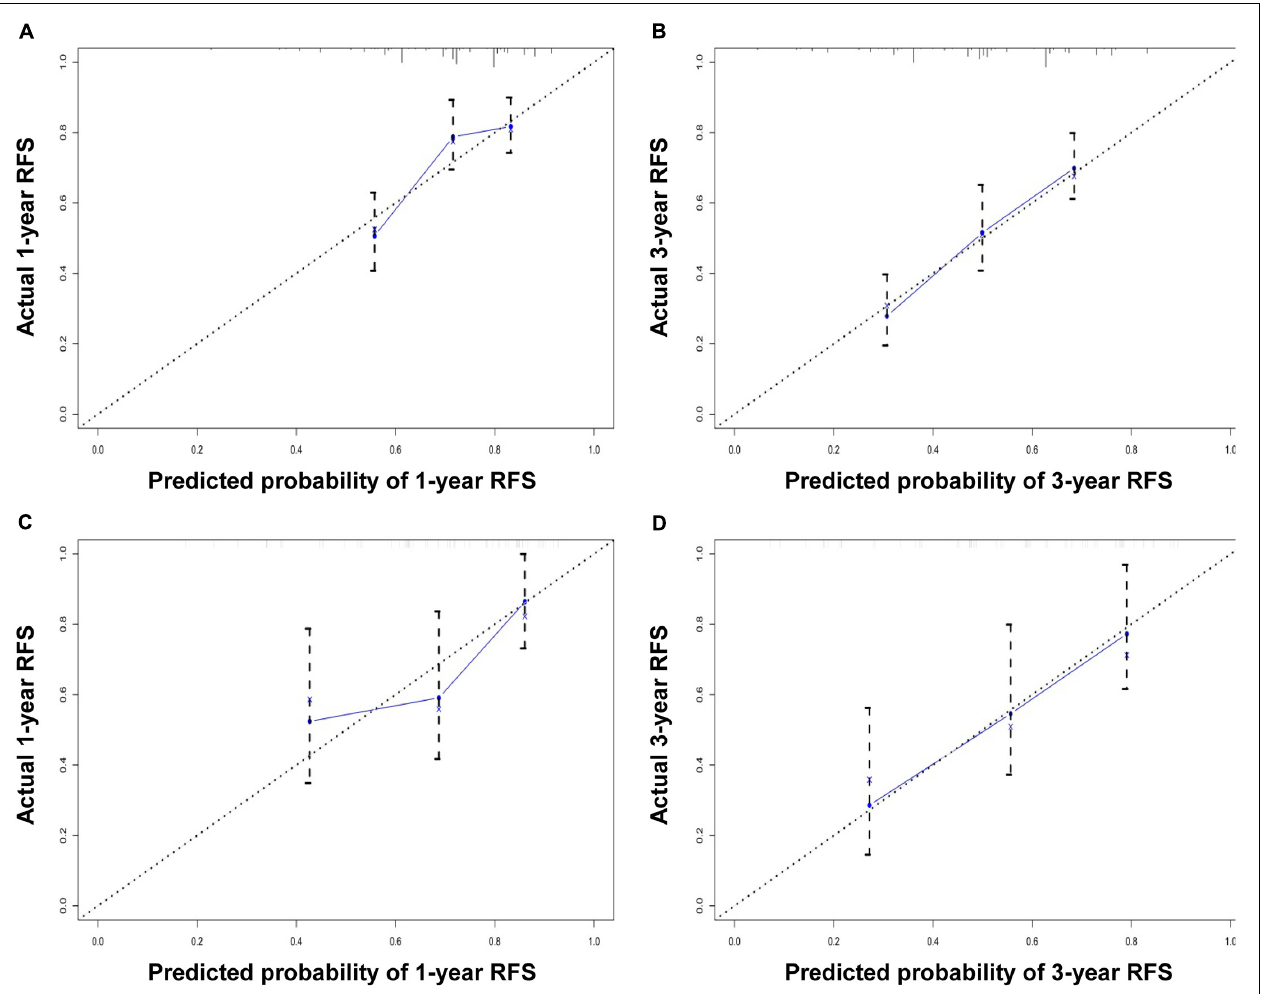
FIGURE 4 | Calibration curve for predicting 1-year RFS (A) and 3-year RFS (B) in the training cohort and 1-year RFS (C) and 3-year RFS (D) in the validation cohort. The nomogram-predicted probability of RFS is plotted on the x -axis; the actual RFS is plotted on the y